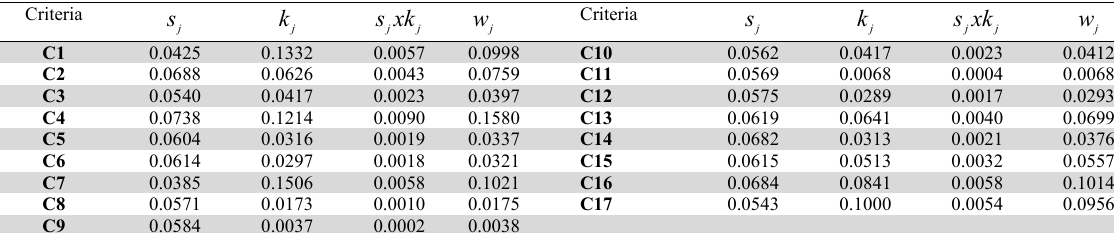
w for each attributes j